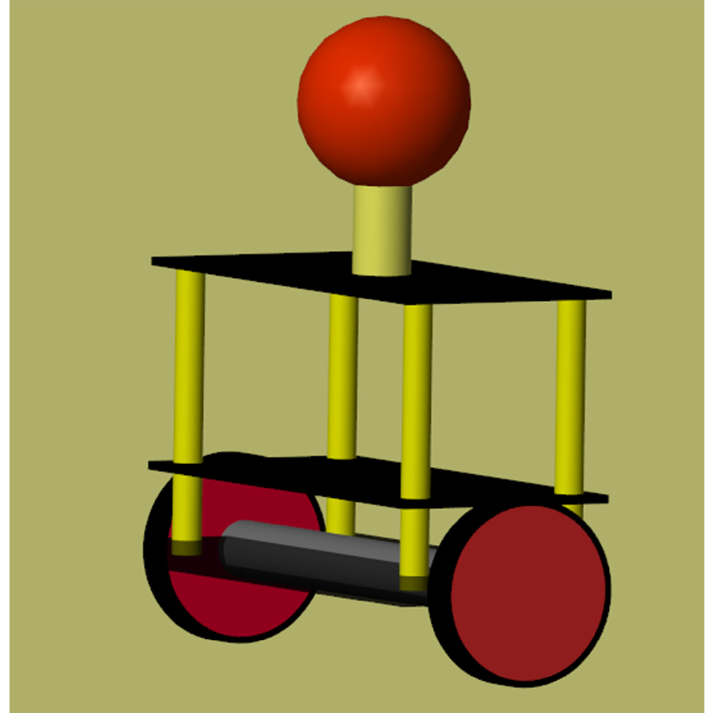
Figure 3. The model of the balancing